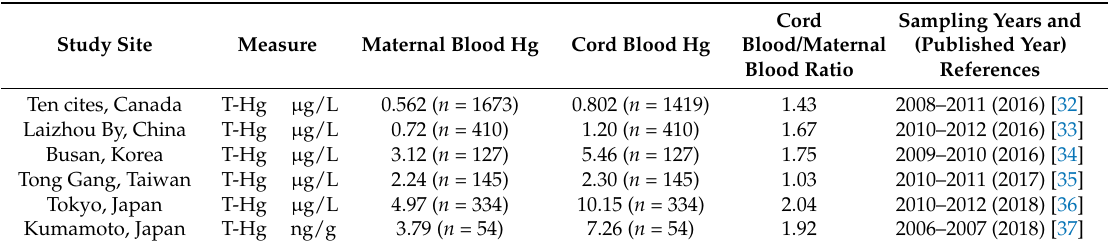
Table 1. Total maternal and cord blood mercury concentrations in various study populations.